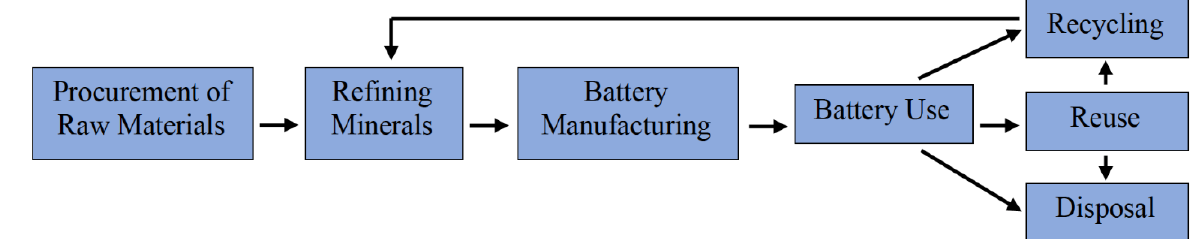
Figure 2. Potential circular economy for lithium-ion electric vehicle batteries.